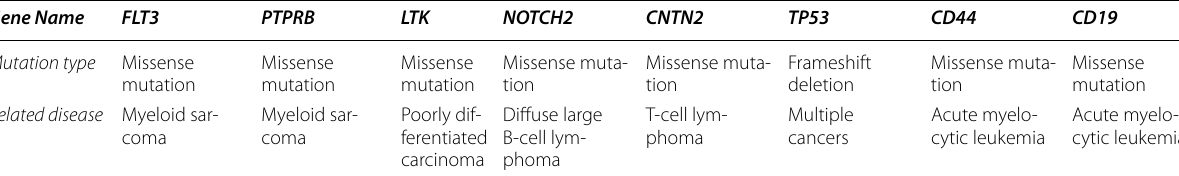
Table 3 Main genes with mutations in our